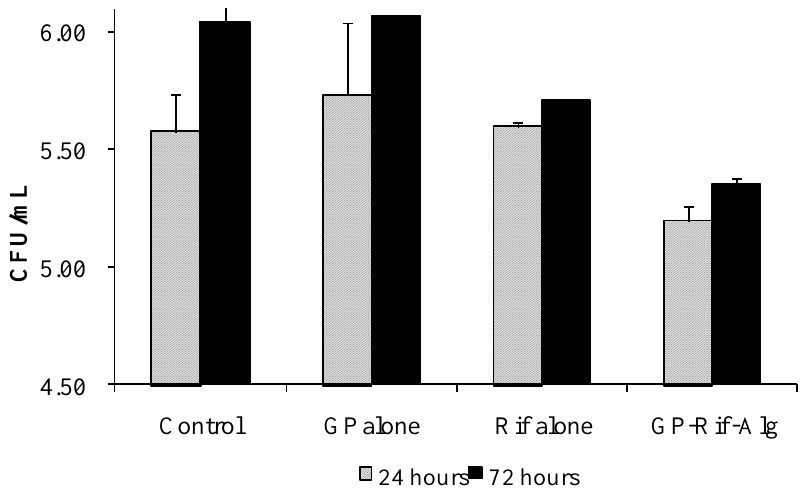
Figure 3. Effect of GP-Rif-Alg (10% w/w Rif/GP) on intracellular M. tuberculosis viability in macrophage